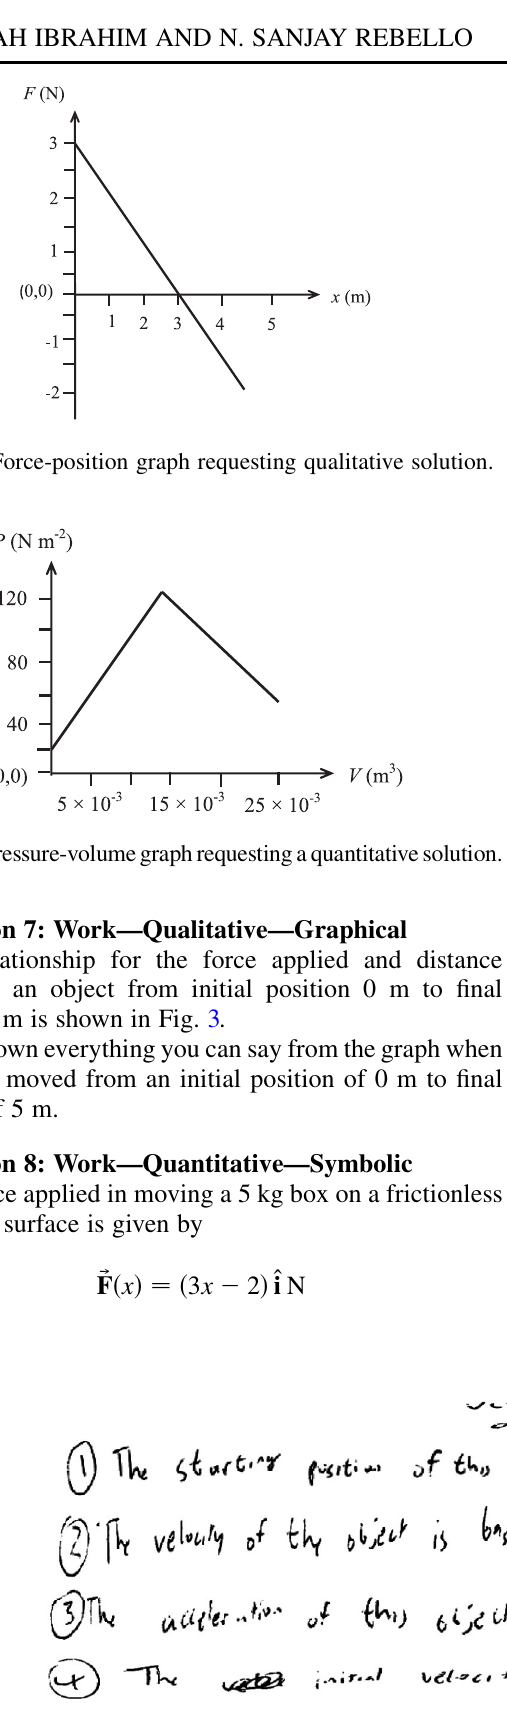
FIG. 5. Example of qualitative solution when interpreting kinematic equation.